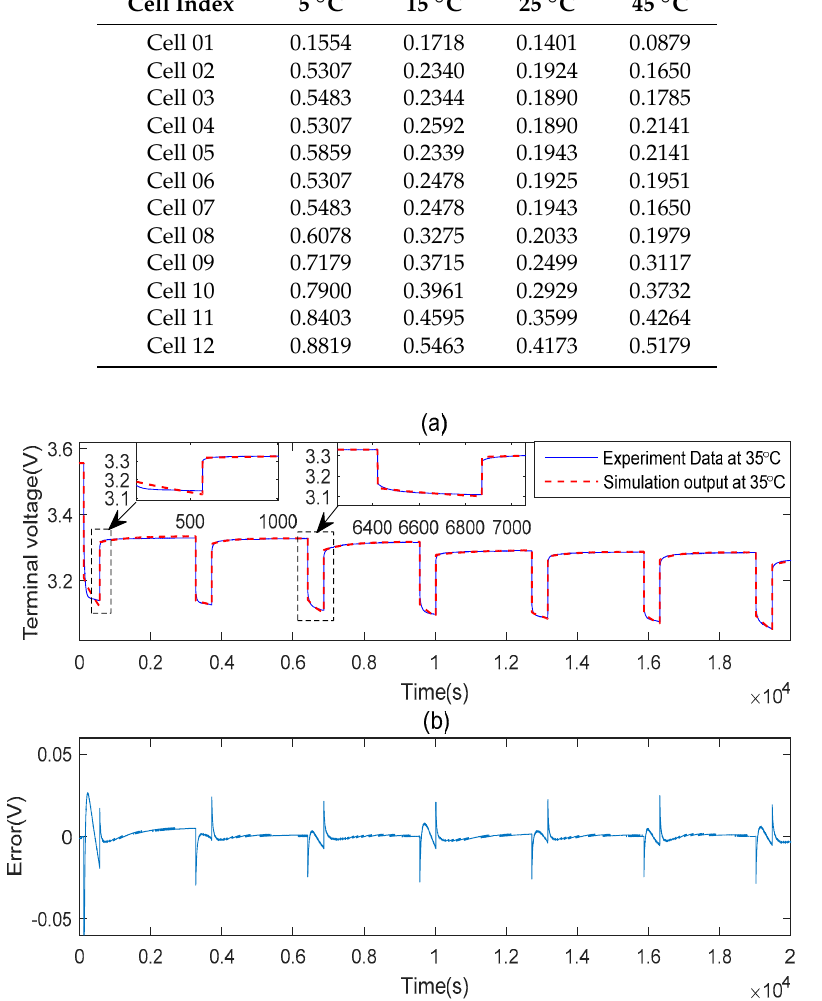
Figure 6. ( a ) Cell #1 model validated at 35 °C; ( b ) corresponding error between simulation and experiment results.